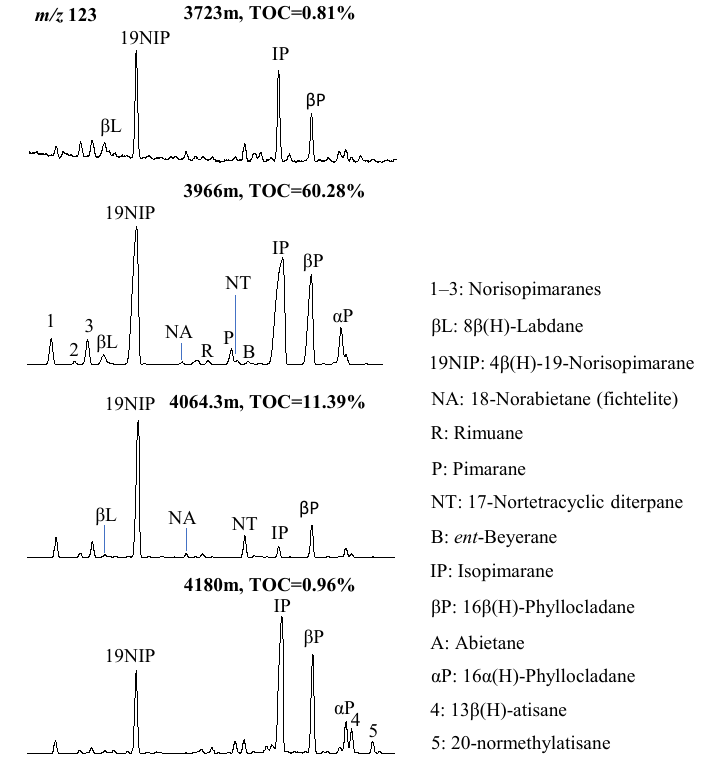
Figure 7. Cross-plot of Pr/ n -C 17 versus Ph/ n -C 18 for the source rocks of the Pinghu Formation. Diterpanes, including bi-, tri-, and tetracyclic components, were detected in all samples analyzed ( m / z 123). They include 8 β (H)-labdane ( β L), 4 β (H)-19-norisopimarane (NIP), fichtelite (18-norabietane, NA), rimuane (R), 17-nortetracyclic diterpene (NT), pimarane (P), ent-beyerane (B), isopimarane (IP), 16 β (H)-phyllocladane ( β P), abietane (A), and 16 α (H)- phyllocladane ( α P) (Figure 8). ent-Kauranes (K) were not detected from the samples. The relative abundance of diterpanes varies significantly in the samples (Figure 5). The diterpanes/n-C 19–20 ratios for the mudstones and carbonaceous mudstones are of 0.06–6.10, and the coal has a high ratio of 33.73 (Figure 6e).